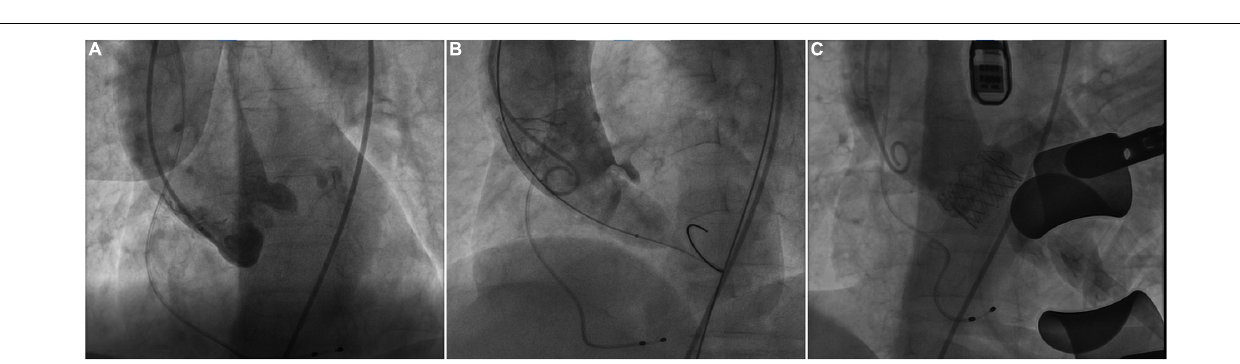
FIGURE 2 | Intraoperative fluoroscopy. (A) Fluoroscopy showed bilateral patent coronary arteries before balloon pre-dilatation. (B) The right coronary artery was invisible and reduced blood flow in the left coronary artery during the balloon dilatation. (C) Fluoroscopy showed the patency of bilateral coronary arteries after J-valve